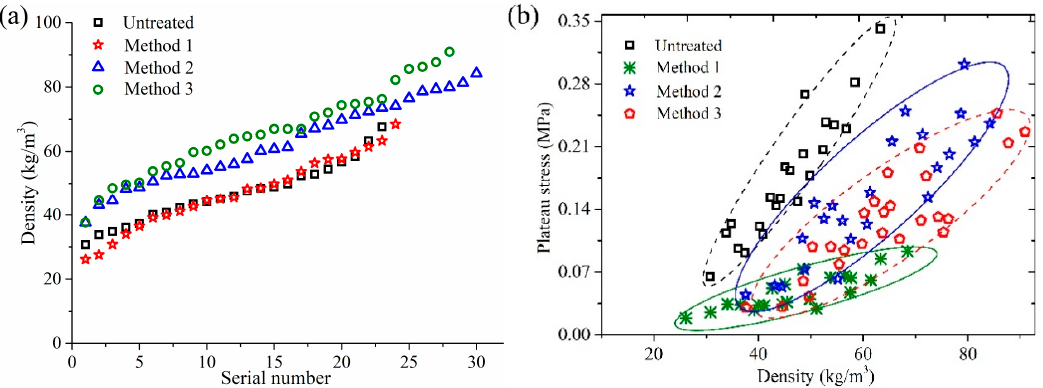
Figure 6. ( a ) Density of CL after treatment with the three methods; ( b ) plateau stress of CL after treatment with the three methods. Table 1. The correlation coe ffi cients of lu ff a density before and after treatment.